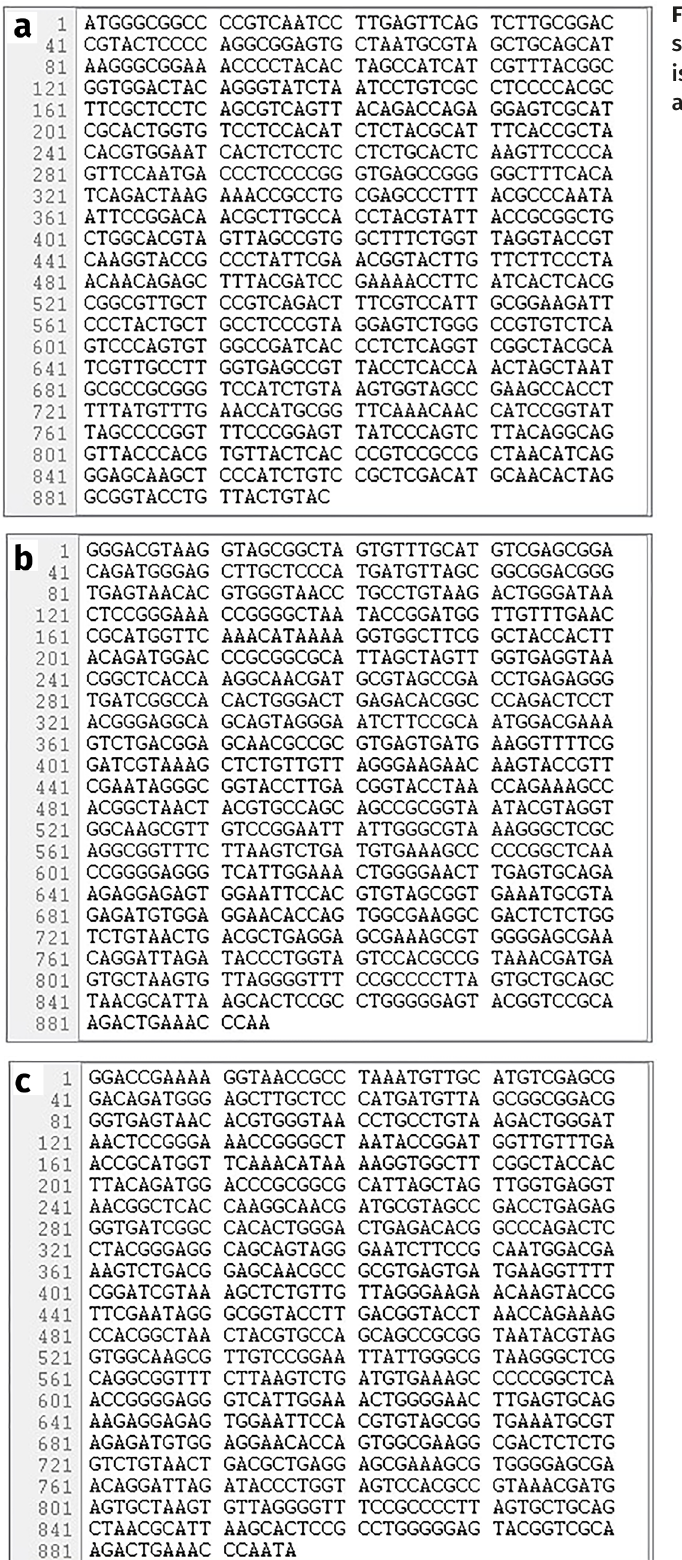
Figure 2. The 16S rDNA sequences generated for isolate MK1 (a), MK2 (b) and MK3